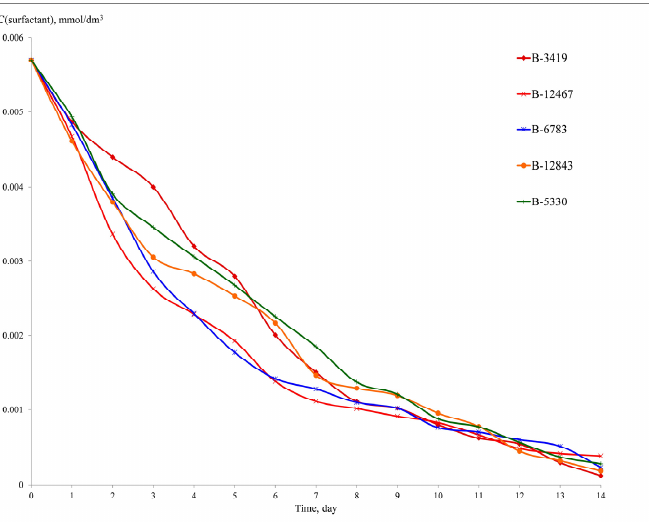
Figure 3. Dependence of CAPB concentration on the duration of biodegradation by Pseudomonas bacteria.